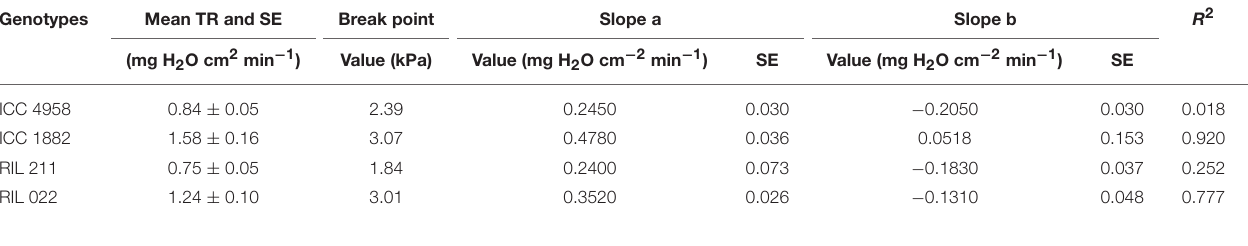
TABLE 2 | Regression (non-linear or segmental) results for the transpiration rate response to increasing VPD in the growth chamber. Genotypes